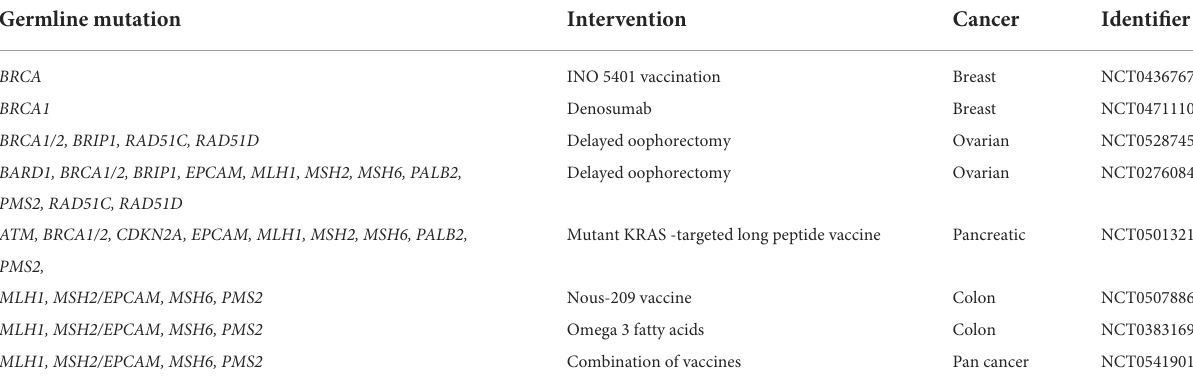
TABLE 8 Interventional clinical trials for cancer prevention among patients with germline cancer mutations in the United States. Germline